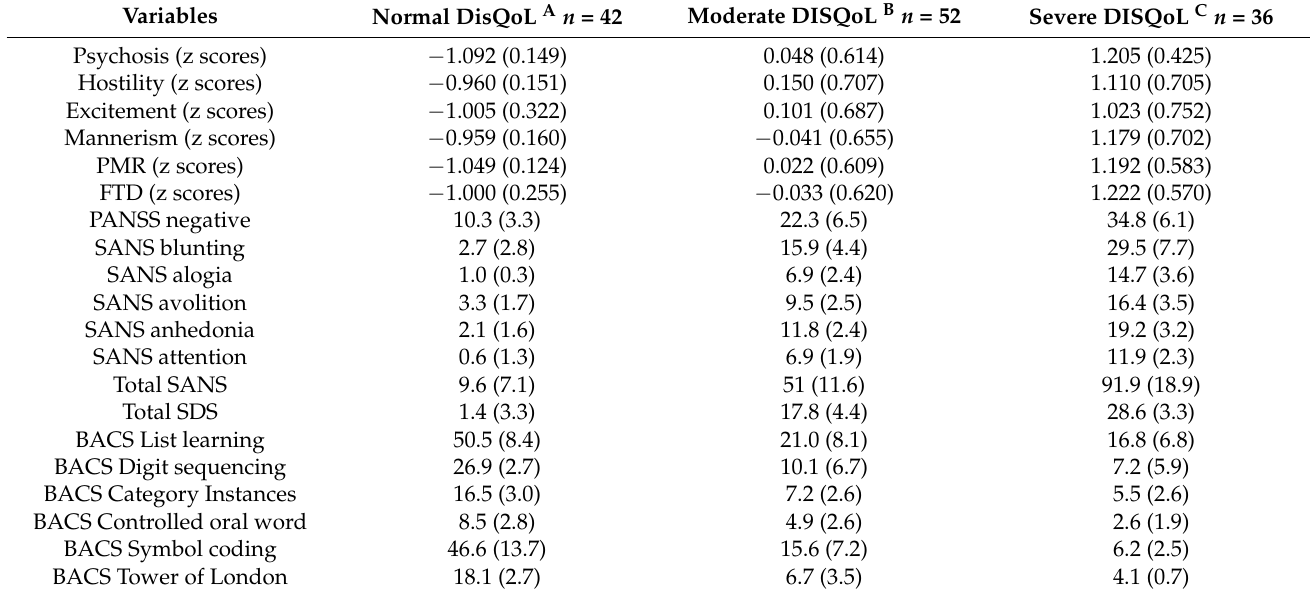
Table 2. Clinical data in healthy controls and schizophrenia patients divided into subjects with severe disabilities and low quality of life (severe DisQoL), moderate changes in disabilities and DisQoL (moderate DisQoL) and those with normal DisQoL values (normal DisQoL). Normal DisQoL A n = 42 Moderate DISQoL B n = 52 Severe DISQoL C n =